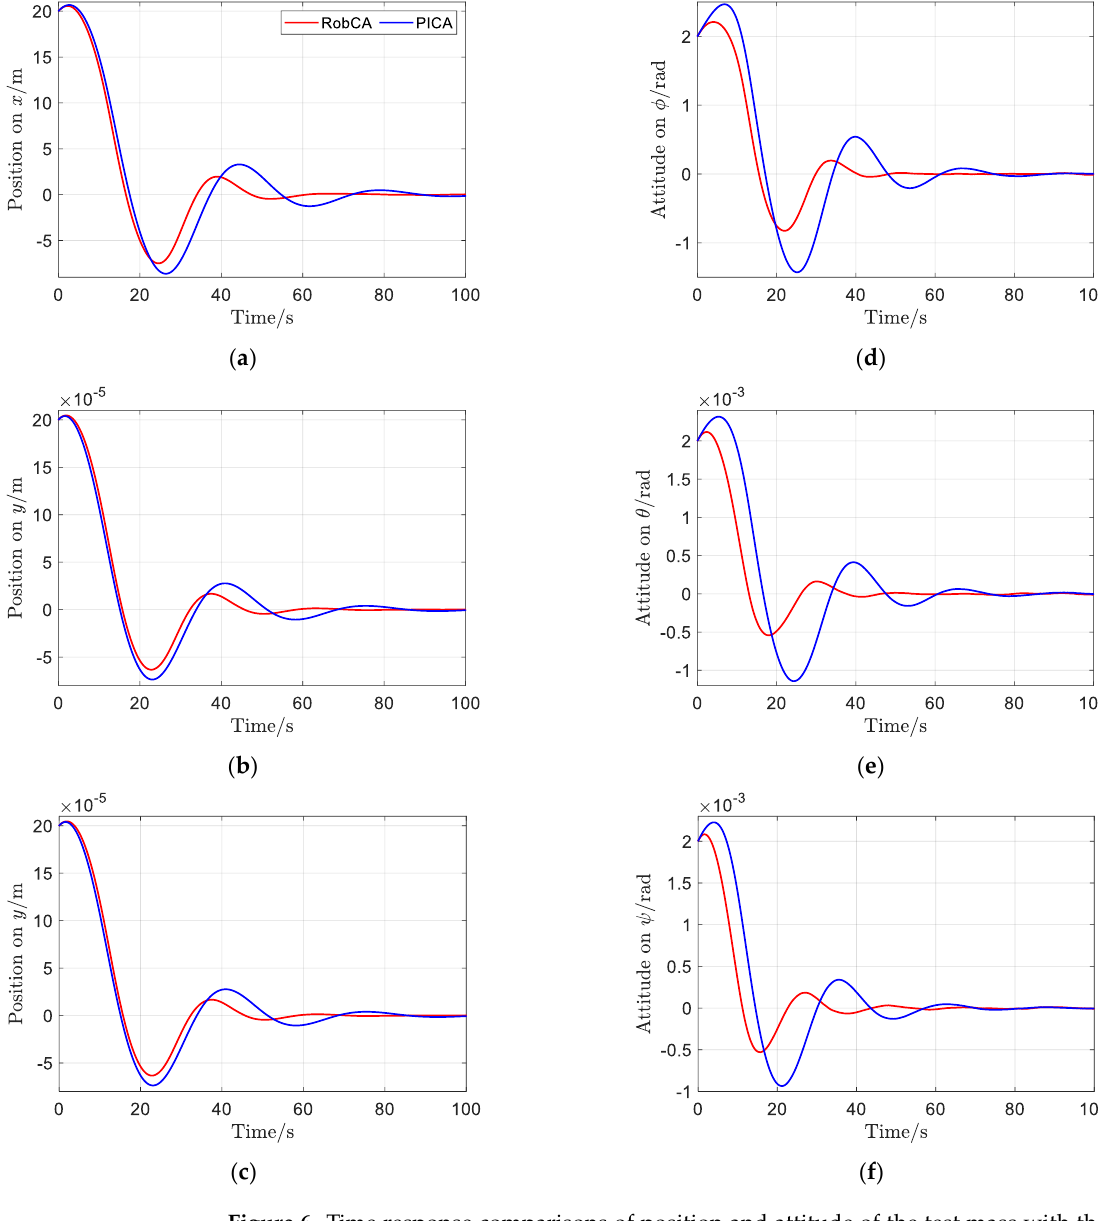
Figure 6. Time response comparisons of position and attitude of the test mass with the proposed RobCA method and the PICA method. ( a ) Position on x . ( b ) Position on y . ( c ) Position on z . ( d ) Attitude on ϕ . ( e ) Attitude on θ . ( f ) Attitude on ψ .